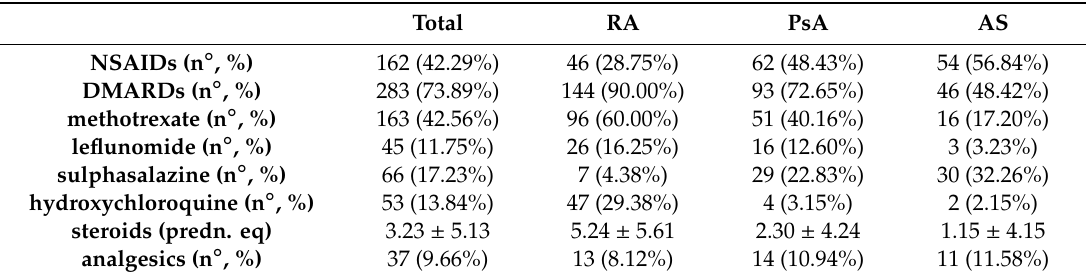
Table 2. Concomitant rheumatic musculoskeletal disease (RMD) medications in association with biological disease-modifying anti-rheumatic drugs (bDMARDs) at baseline (BL) visit. Total RA